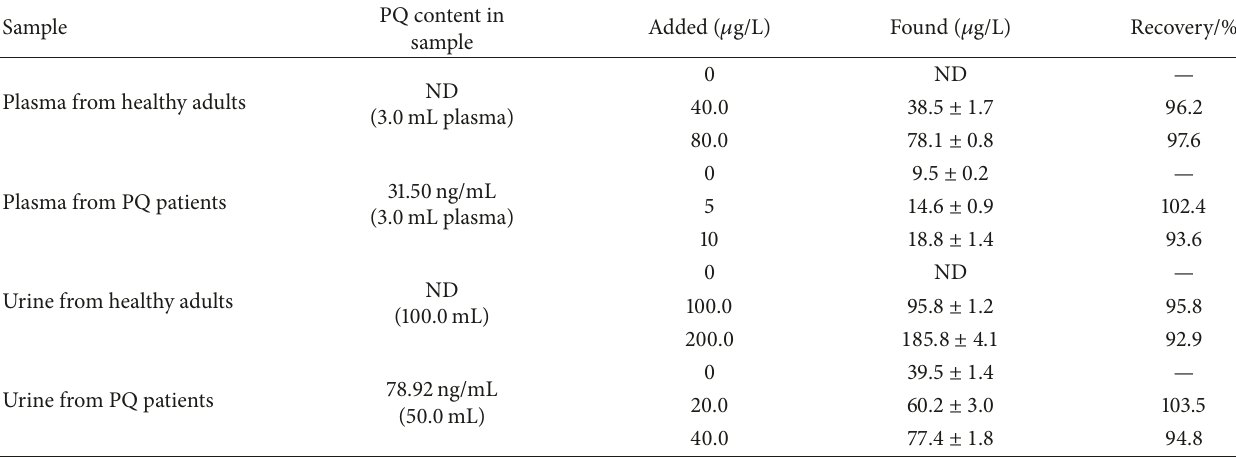
ND, nondetectable.